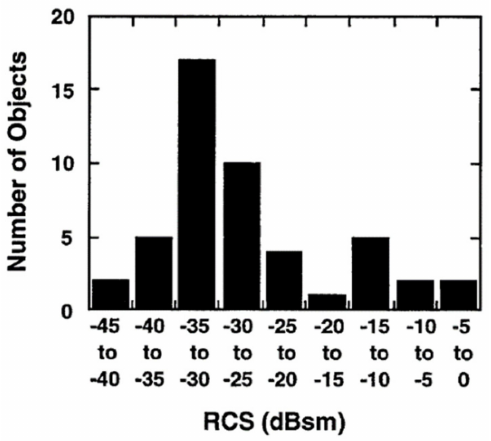
Figure 2. Results from ALTAIR 1994 tracking activities [14]. Reprinted with permission courtesy of MIT Lincoln Laboratory, Lexington,